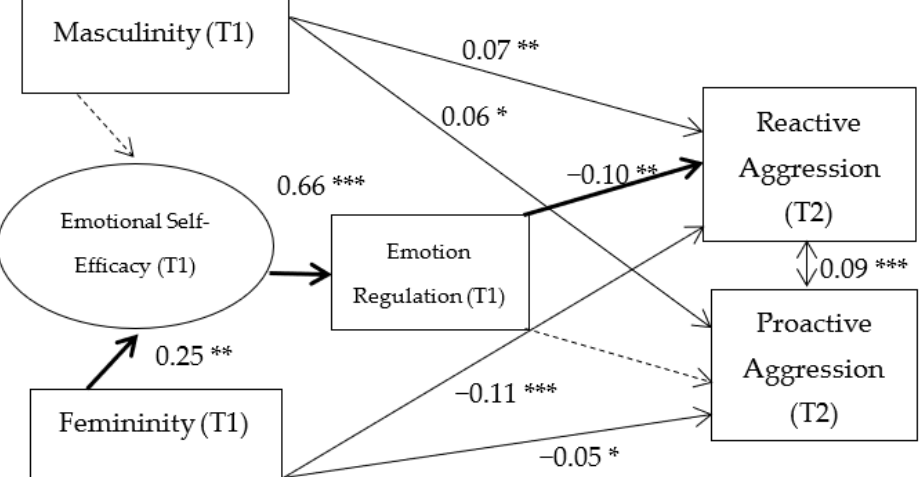
Figure 2. Path model of the relations among reactive aggression, proactive aggression, emotion regulation, regulatory emotional self-efficacy, masculinity, and femininity across youth from Spain. Standardized coefficients are depicted. T1 = Time 1; T2 = Time 2. Emotional self-efficacy = regulatory emotional self-efficacy. Normal arrows depict significant relationships. Interrupted arrows depict non-significant relationships. Indirect effects are depicted in black. * p < 0.05; ** p < 0.01; *** p < 0.001. Bias corrected bootstrap confidence intervals suggested that there was a significant indirect effect from femininity to reactive aggression via regulatory emotional self-efficacy and emotion regulation (( β = − 0.04, p = 0.02) (Table 2) (Hypothesis 1). In testing mod- eration by gender, the unconstrained model [ χ 2 (10) = 36.48] and the constrained model [ χ 2 (24) = 18.96] were not significantly different as determined by a chi-square difference test [ χ 2 (14) = 17.43, p = 0.23], suggesting no moderation by gender (Hypothesis